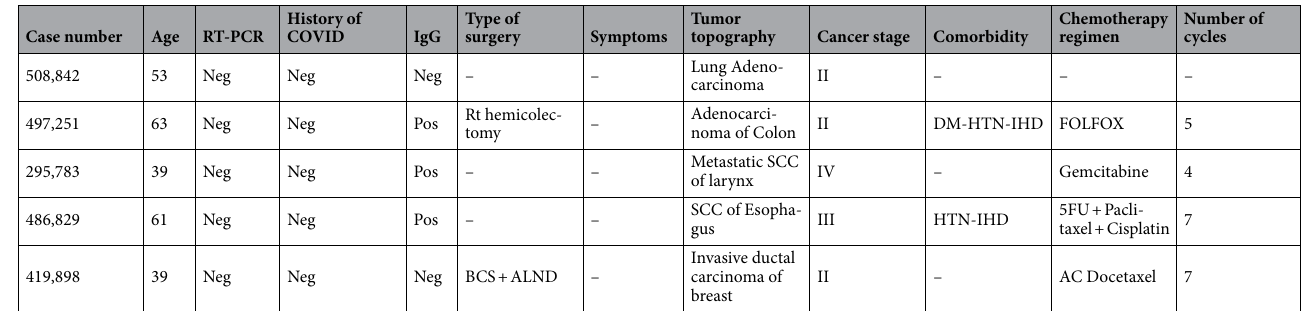
Table 4. Clinical characteristics of COVID-19 infected cancer patients according to the IgM test